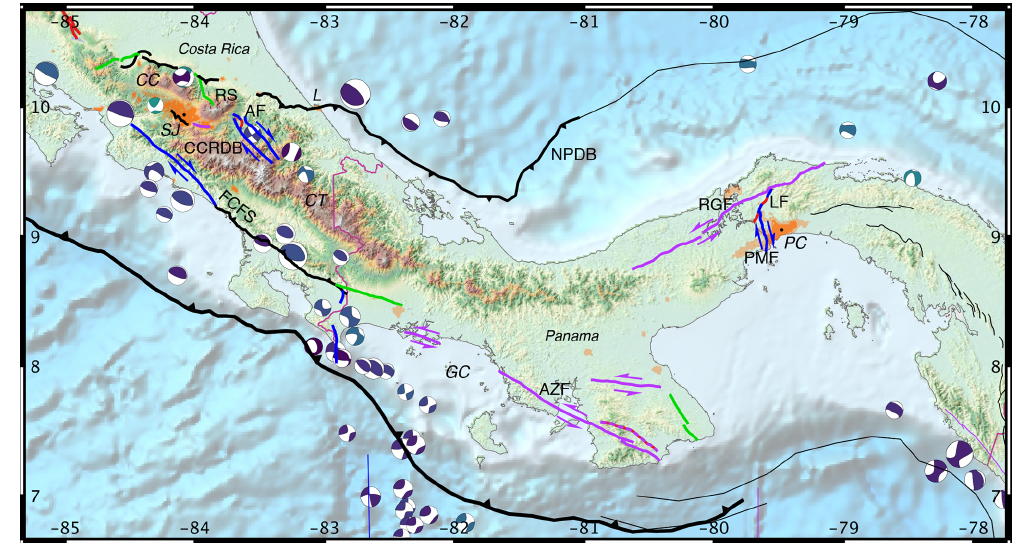
Figure 6. Active faults of Costa Rica and Panama. RS is the Riosucio fault. AF is the Atirro fault. CCRDB is the central Costa Rica deformed belt. FCFS is the Fila Costeña fault system. RGF is the Río Gatún fault. LF is the Limón fault. PMF is the Pedro Miguel fault. AZF is the Azuero